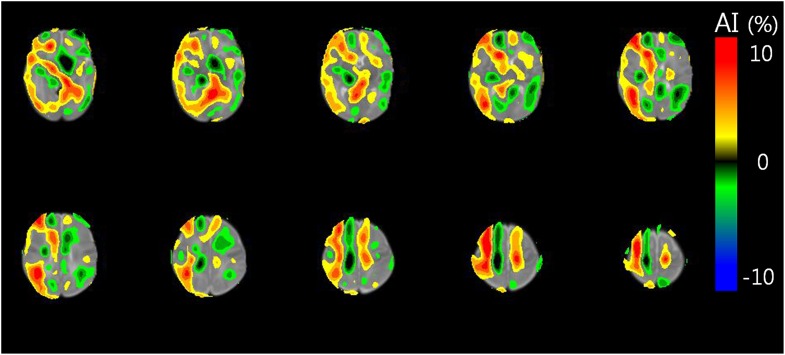
Voxelwise asymmetry index (AIvbm) of cerebral glucose metabolism in a very low-birth-weight infant.Voxel-based morphometry revealed right dominant asymmetry of cerebral glucose metabolism. Red indicates a region of relatively high glucose metabolism (where AIvbm is positive) in comparison to corresponding regions. Blue indicates a region of relatively low glucose metabolism (where AIvbm is negative) in comparison to corresponding regions.